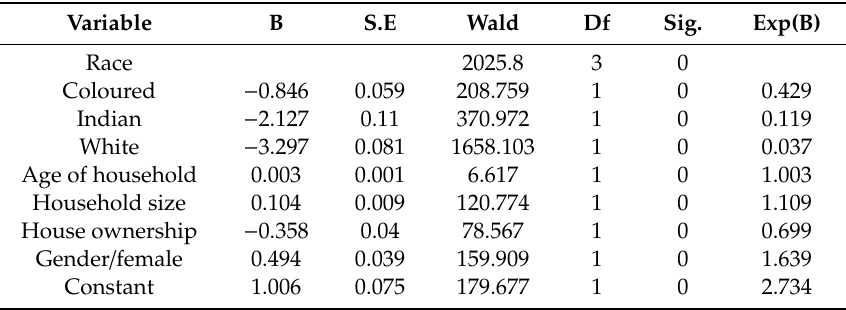
Table 4. Logistic regression